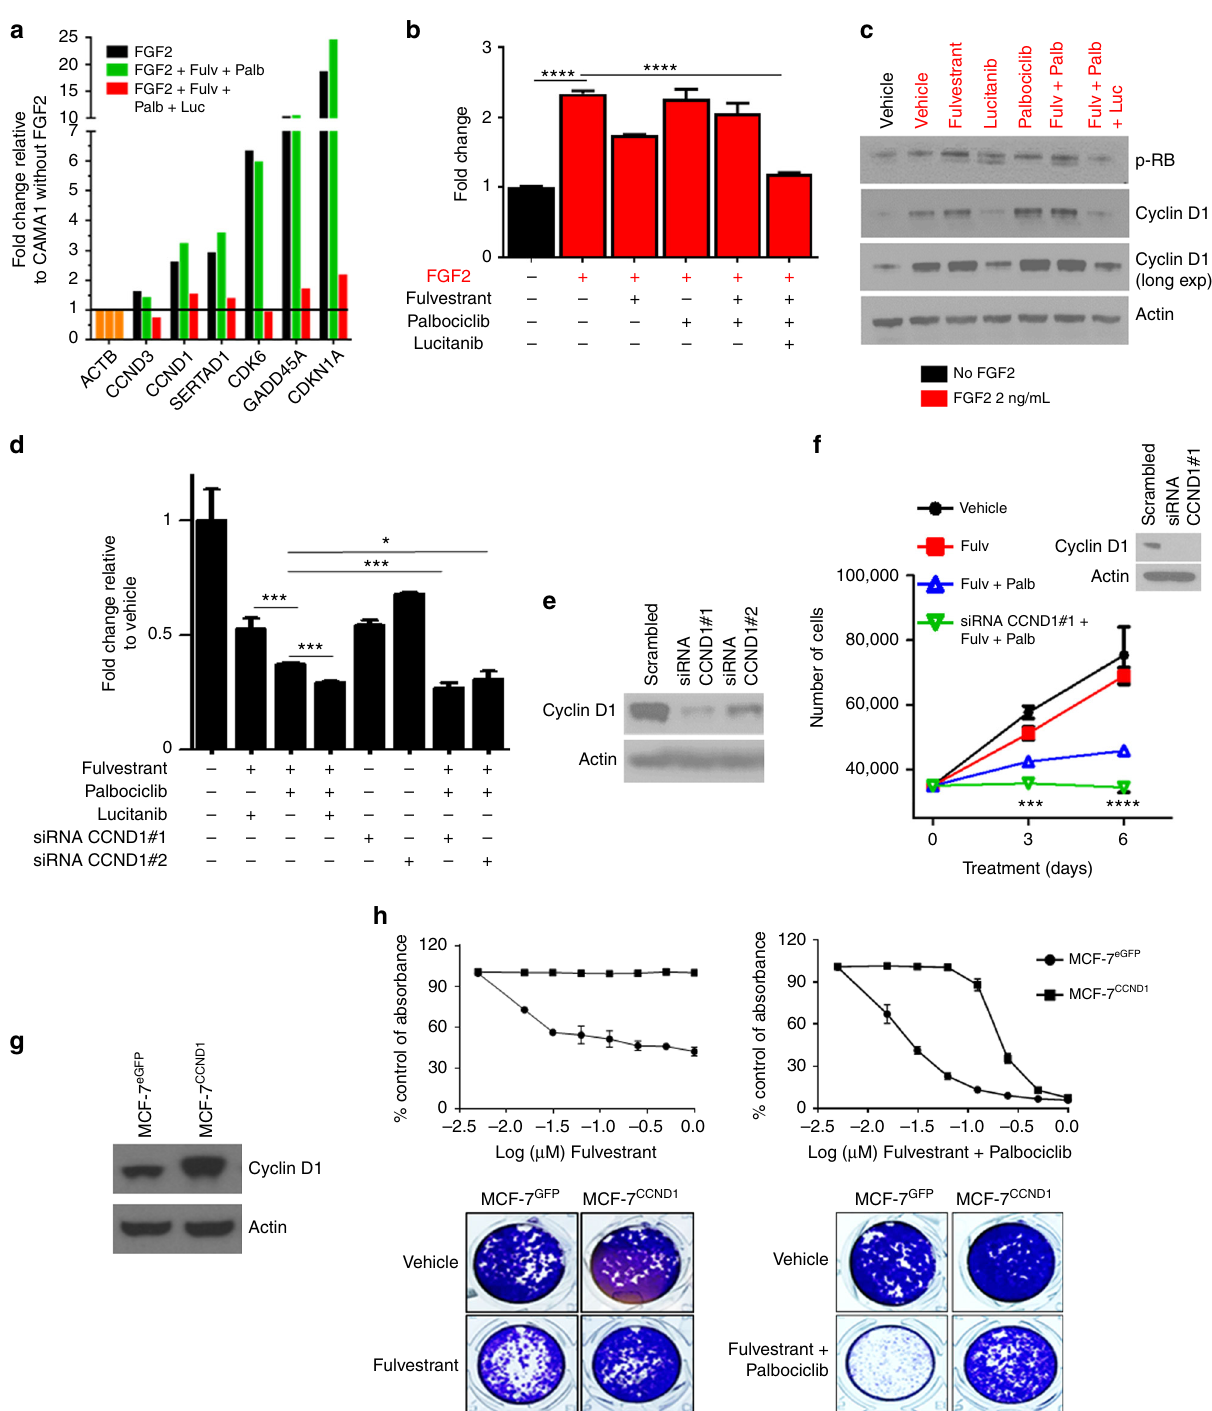
Baseline tumor samples from patients in MONALEESA-2 were assessed for mRNA expression using the NanoString 230-gene nCounter GX Human Cancer Reference panel. Evaluable mRNA expression data from baseline tumor samples were obtained from 391 of 668 (58.5%) randomized patients. To assess correlations between gene expression level and PFS, patients were classi fi ed into low and high mRNA expression subgroups using median expression (50%) as the cut-off. Patients with high FGFR1 mRNA expression that were treated with ribociclib plus letrozole showed a median PFS of 22.21 months. In patients with low FGFR1 mRNA, a median PFS has not been reached after a follow-up